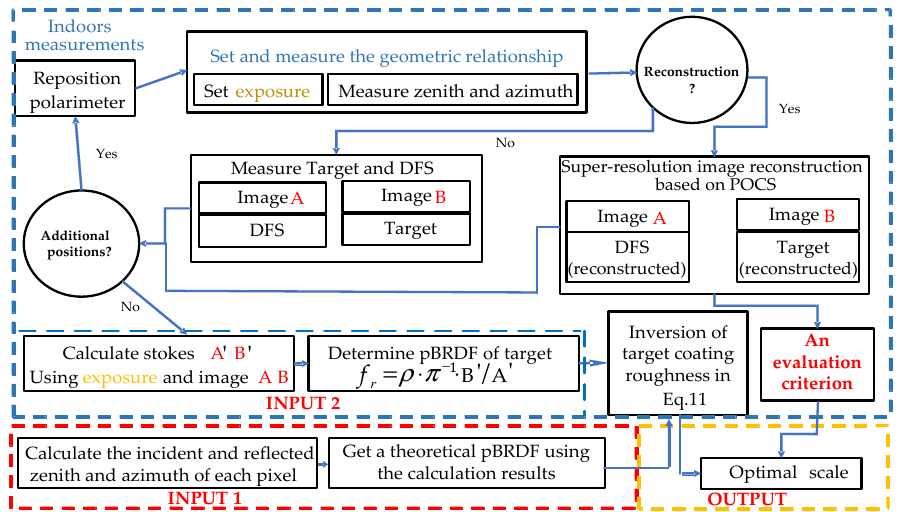
Figure 9. Scheme of experiment 2.